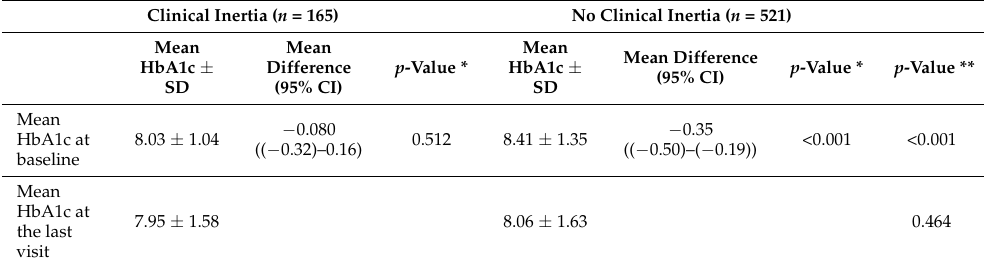
Table 3. The difference in mean